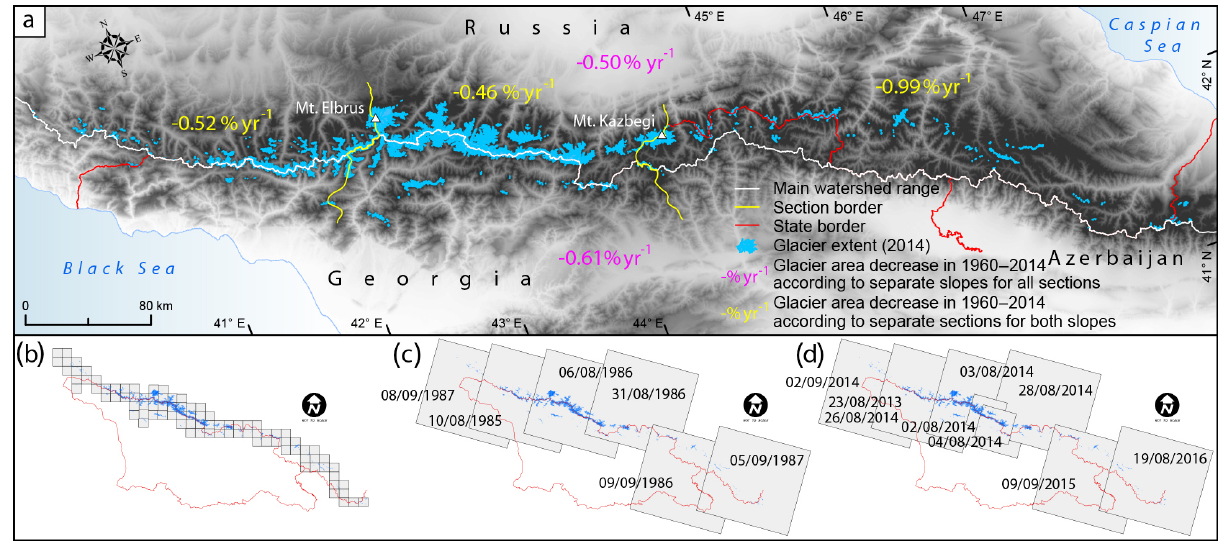
Figure 1. (a) Distribution of the Greater Caucasus glaciers. (b) 1960s 1 : 50000 scale map sheets (88) are based on aerial photographs, 1950–1960. (c) Six Landsat 5 TM satellite scenes, 1985–1987. (d) Seven Landsat 8 OLI satellite scenes from 2013 to 2016 and two (smaller) ASTER satellite scenes from